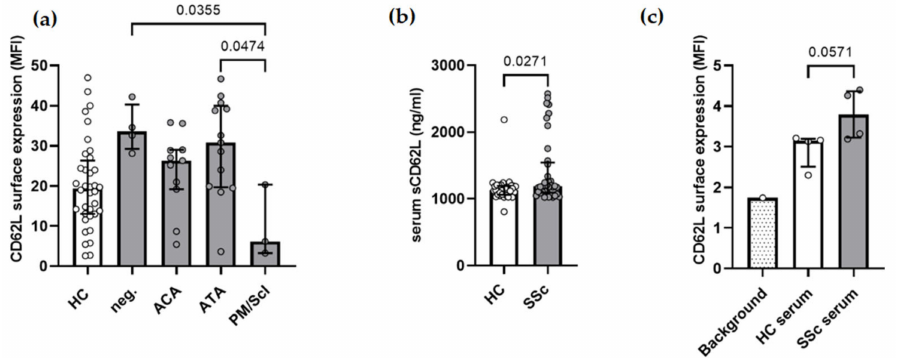
Figure 3. CD62L in SSc. ( a ) The surface expression of CD62L in SSc monocytes is associated with the autoantibody profile of the patients. CD62L is highest in patients negative for ACA, ATA, and PM/Scl, followed by ATA-positive patients and ACA-positive patients and the lowest in patients positive for PM/Scl antibodies. ( b ) Soluble CD62L in serum is significantly higher in the SSc patients than in the healthy controls. ( c ) Monocytes treated for 24 h with 50% serum from ATA-positive SSc patients ( n = 4) express more surface CD62L than monocytes treated with serum from the healthy controls ( n = 4). Values are shown as the median and interquartile range of median fluorescence intensity (MFI) ( a , c ) and the soluble serum CD62L concentration ( b ). ACA—anti-centromere antibodies; ATA—anti- topoisomerase I antibodies; HC—healthy controls; PM/Scl—anti-PM/Scl antibodies; SSc—systemic sclerosis.